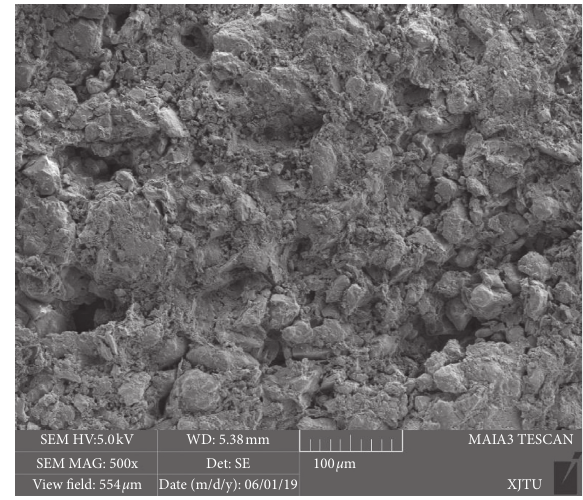
Figure 5: SEM observation of intact soils in